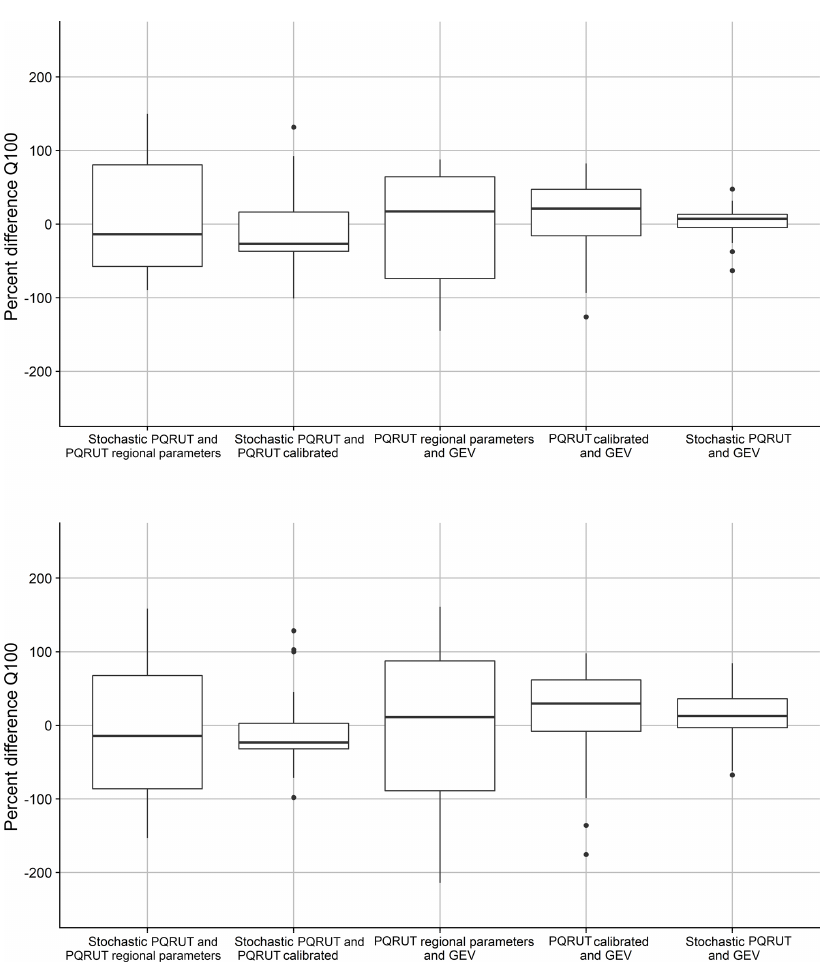
Figure 12. Box plots showing the distribution of the differences (calculated by dividing the estimates by the average of all of the models) between the stochastic PQRUT, PQRUT and GEV for the 100- and 1000-year return